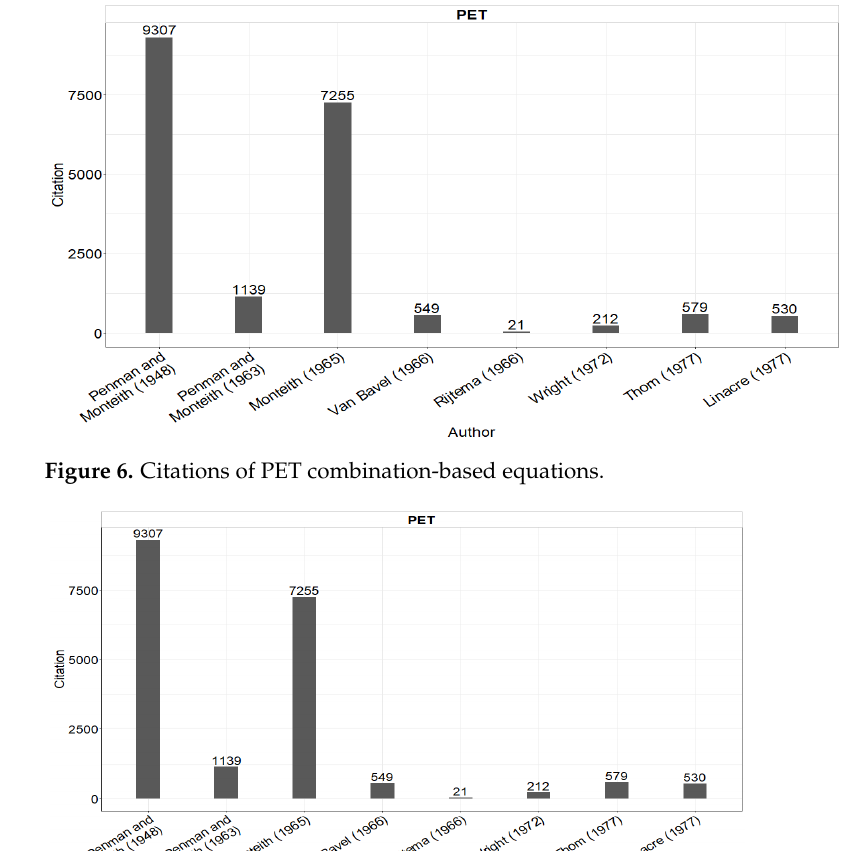
Figure 7. Citations for RET combination-based equations.